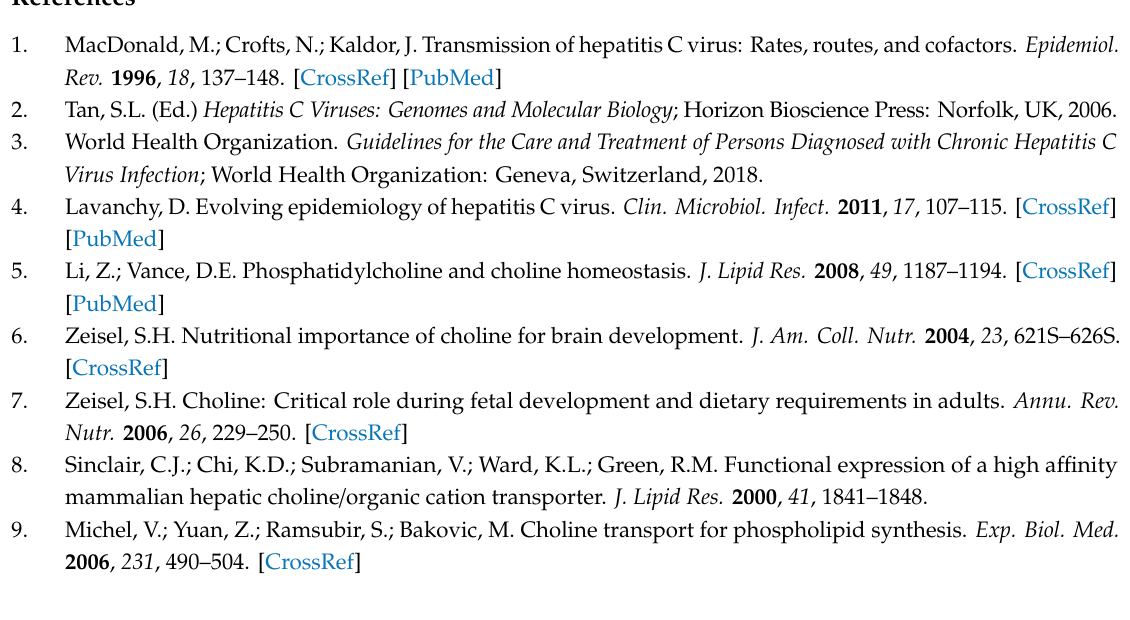
Table S1: qPCR primer sequences, Figure S1: FBS-cultured Huh7.5 choline transporter transcript expression, Figure S2: HS-cultured Huh7.5 choline uptake kinetics, Figure S3: Inhibition of choline transport in FBS-cultured infected cells, Figure S4. Graphical